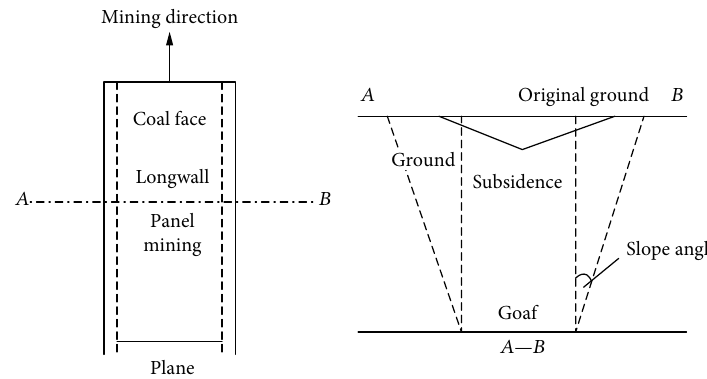
Figure 1: Mining mobile